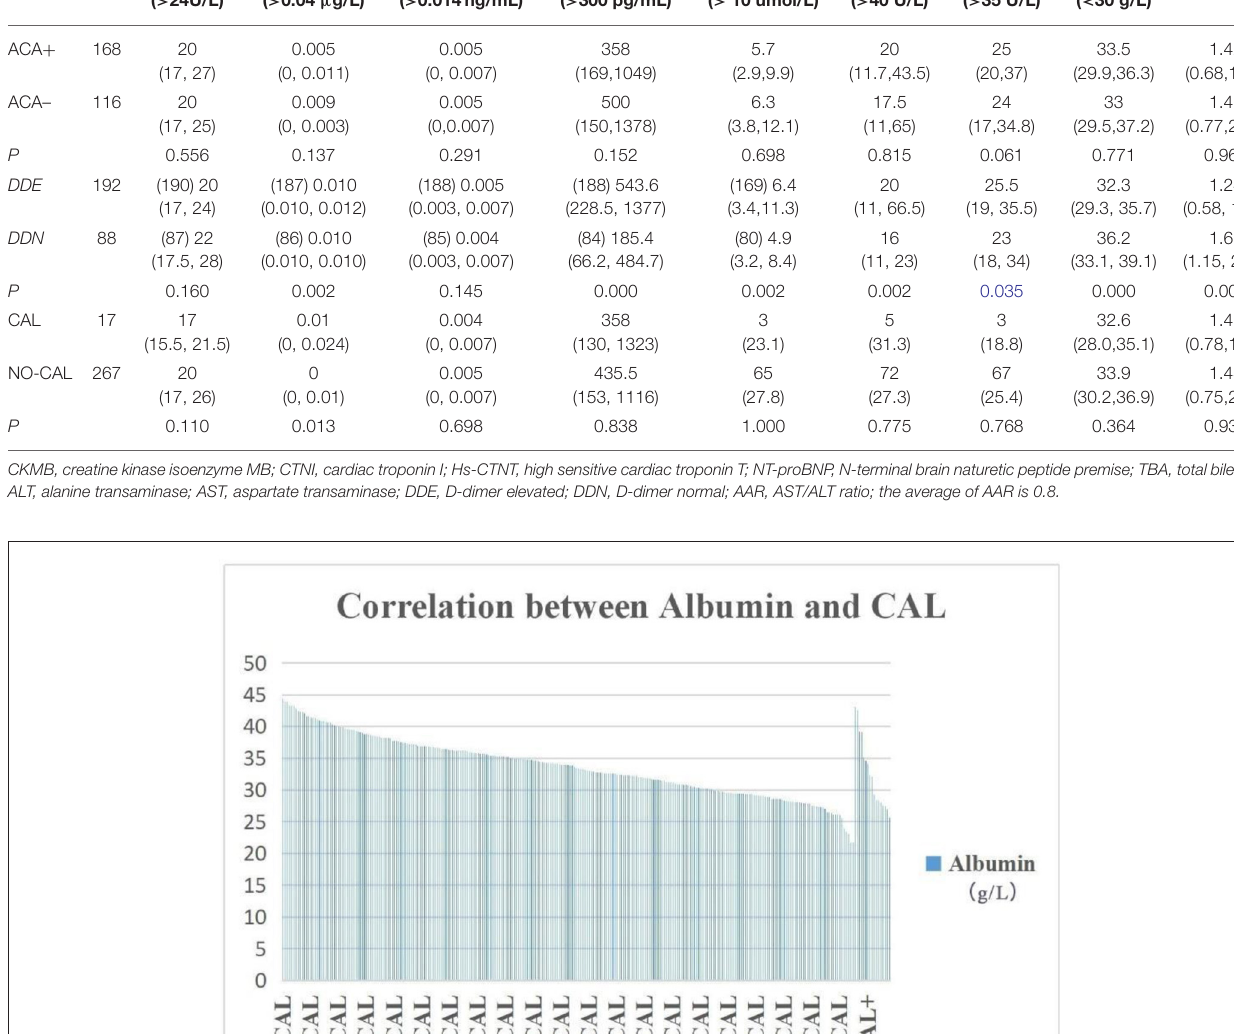
Based on the reported average of AAR at 1.1 by Wang et